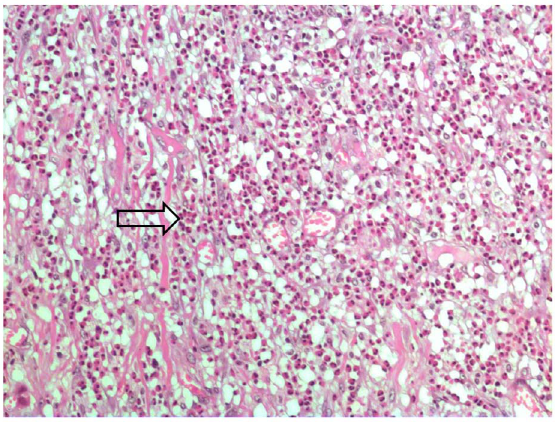
Figure 3. Eosinophilic infiltration (arrow) in bowel wall (H&E, 200x).